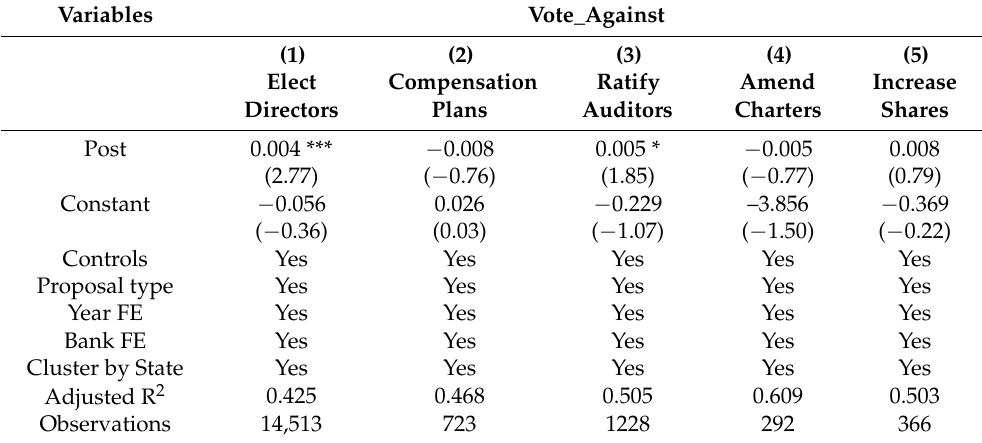
Table 10. Sub-samples based on proposal